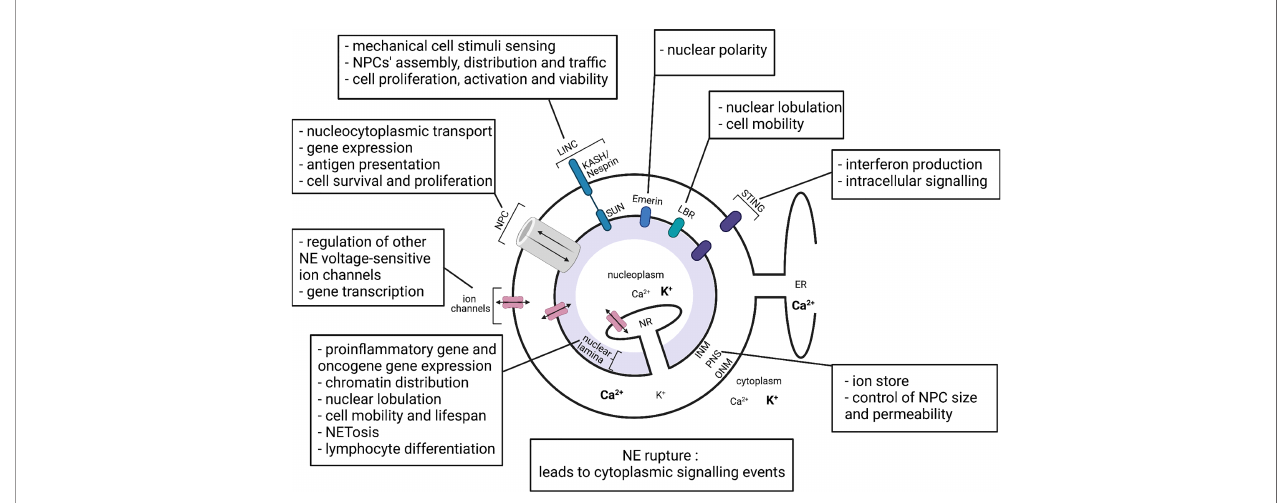
FIGURE 1 | Representation of the nuclear envelope components and their proposed functions in immune cells. INM, inner nuclear membrane; ONM, outer nuclear membrane; PNS, perinuclear space; NR, nucleoplasmic reticulum; ER, endoplasmic reticulum; NPC, nuclear pore complex; LINC, linker of nucleoskeleton and cytoskeleton complex; LBR, lamin B receptor; STING, stimulator of interferon genes. Bold text represents higher ion concentration. Created with